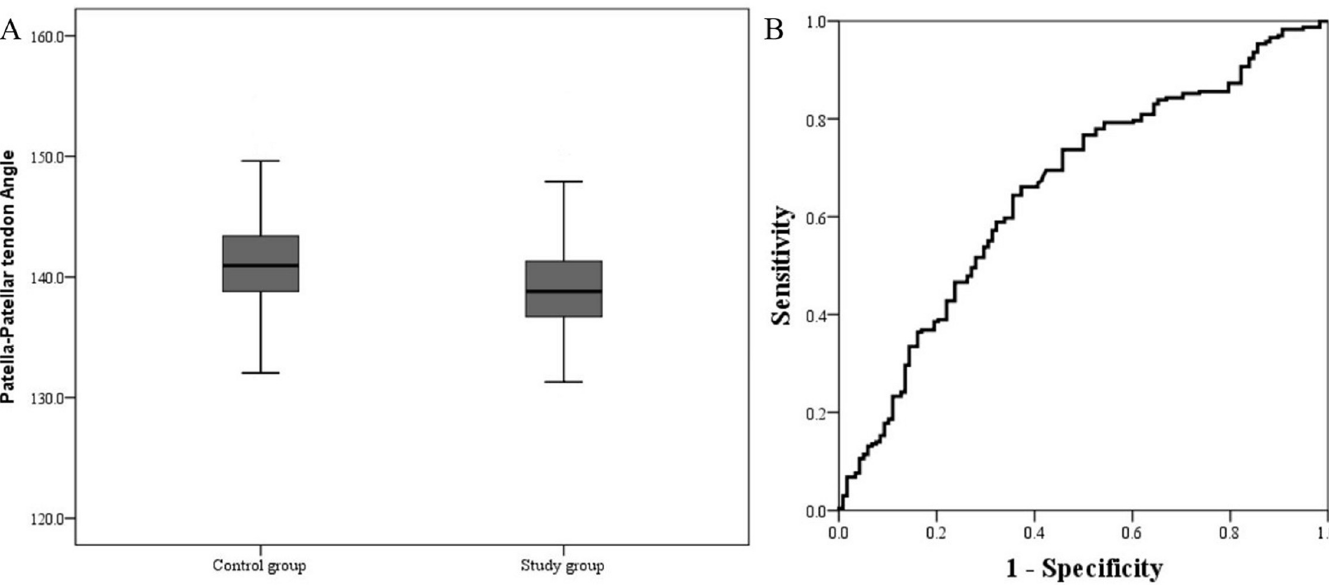
Fig 3. Comparison of PPTA between the two groups (study group vs. control group) and receiver operating characteristic (ROC) analysis to assess the performance of PPTA for the prediction of the risk of knee patellofemoral joint disorder. (a) Box-plot showed mean PPTA was significantly lower in study group than control group (138.1 ± 4.2˚ vs. 142.1 ± 4.3˚, p < 0.001). (b) The ROC curve of PPTA for predicting the patellofemoral joint disorder showed the AUC of 0.696 at a cutoff value of 138.3˚, with a sensitivity of 70.3% and a specificity of 57.6%.